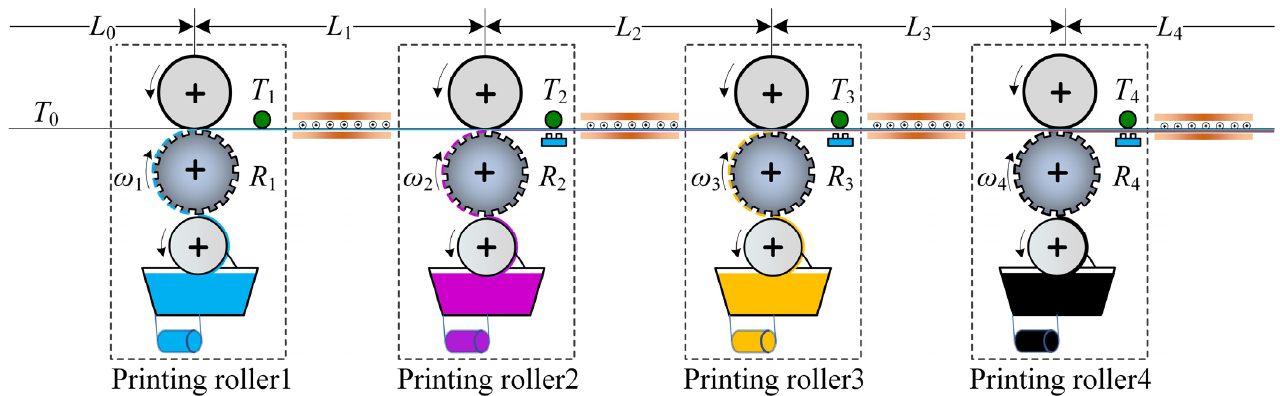
Figure 2. Four-color printing register model description.